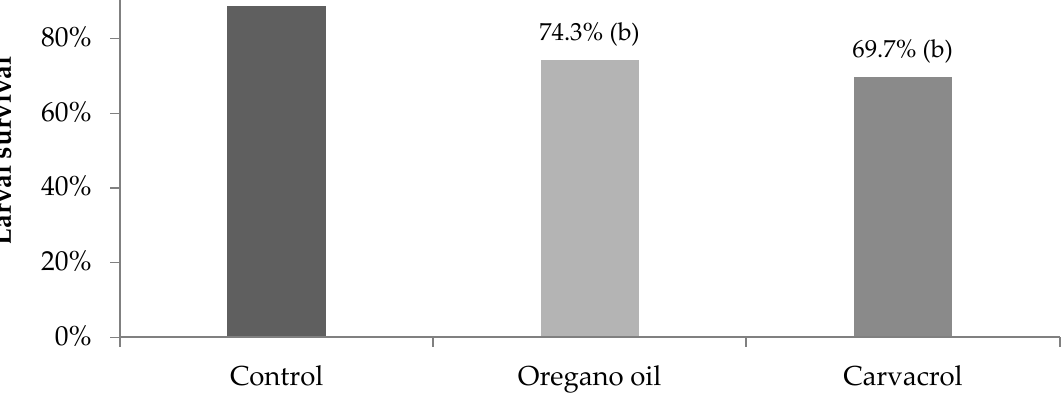
Figure 1. Larval survival (%) of Cx. pipiens biotype molestus mosquitoes that remained alive after 24 h exposure of 3rd–4th instar larvae to LC 50 concentrations of oregano oil ( n = 74) and carvacrol ( n = 99), and to water solution of 2% DMSO (control) ( n = 80). Percentages in a column followed by a different letter are significantly different ( p < 0.05).